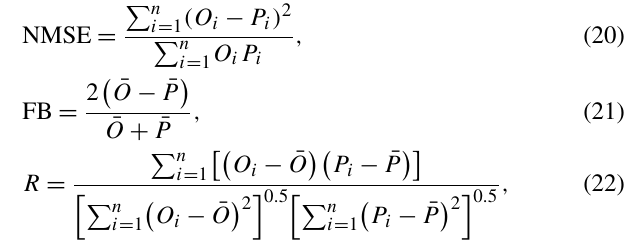
residuals at convergence are 1 × 10 − 6 , 1 × 10 − 9 , and 1 × 10 − 6 for U x , U y , and U z , respectively; 1 × 10 − 7 for continuity; 1 × 10 − 6 for k ; and 1 × 10 − 6 for ε .